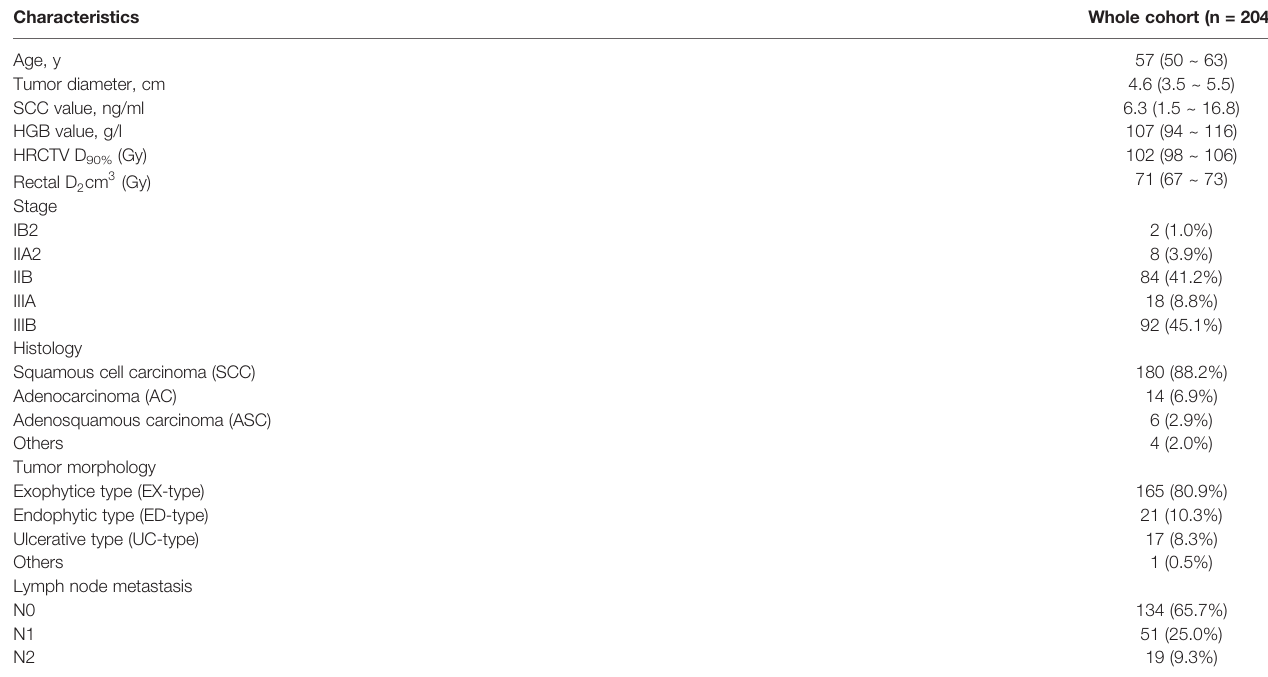
TABLE 1 | Clinical characteristics of patients with LACC.